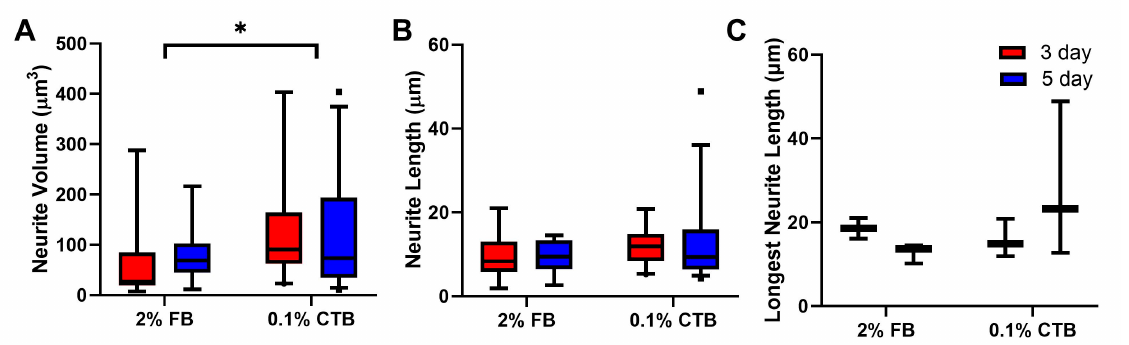
Figure 9. Total neurite volume, length, and longest path in aged mice (25 months). ( A ) Total neurite volume among tracer protocols. ( B ) Total neurite length of aged cells among the two tracer protocols. The total neurite length was calculated as the sum of L1, L2, . . . , L10. ( C ) Longest neurite path of the two tracer protocols. Data are median ± 95% confidence interval. The rectangles are data points outside the 95% confidence interval for the 5-day protocols. * denotes p < 0.05.